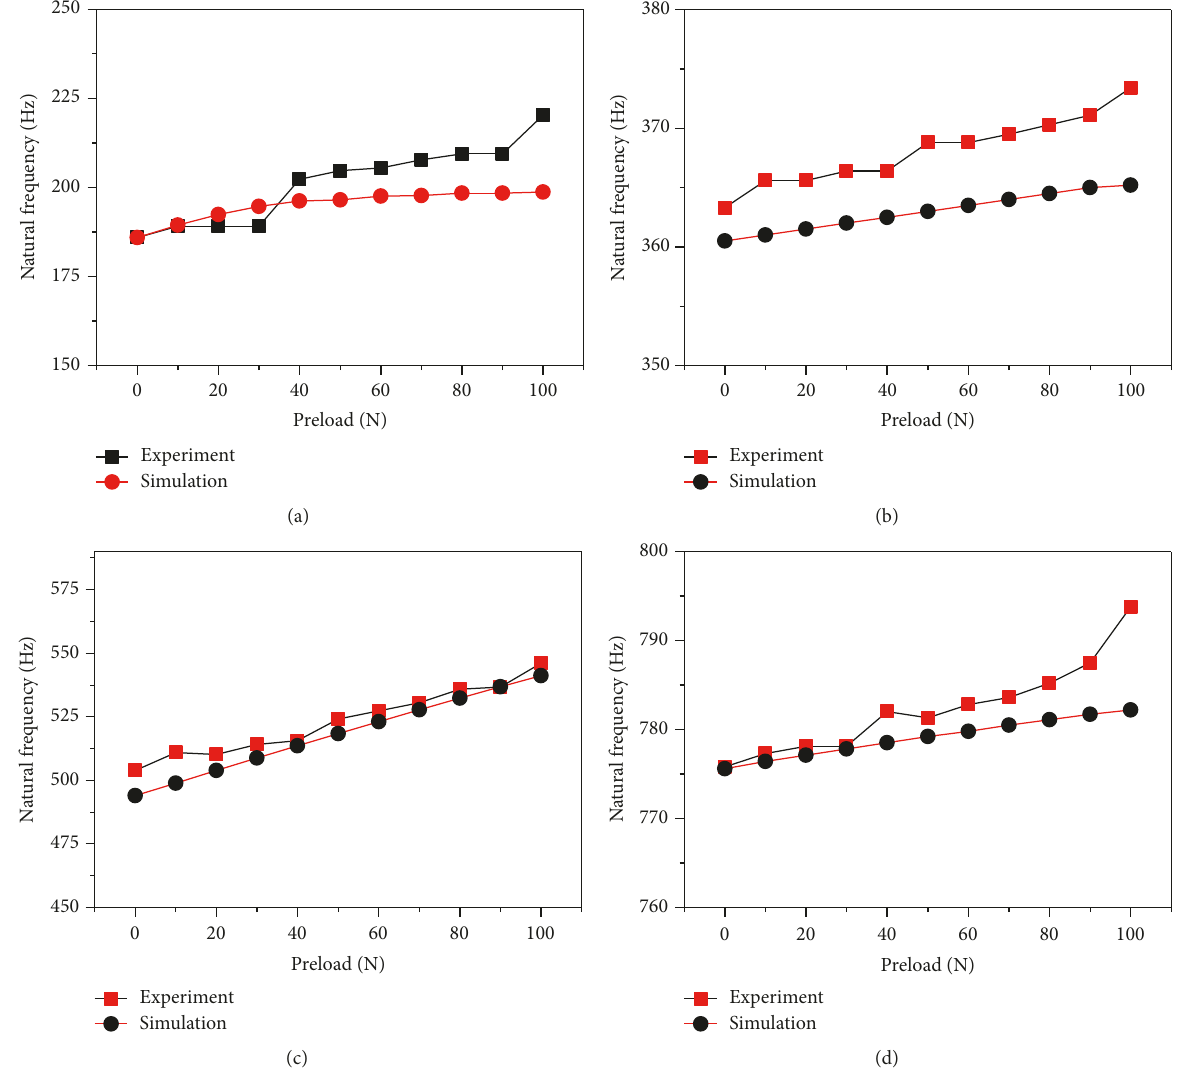
Figure 7: Contrast curves of simulation and experimental values of the natural frequency of the first four orders. (a) First-order natural frequency. (b) Second-order natural frequency. (c) Third-order natural frequency. (d) Fourth-order natural